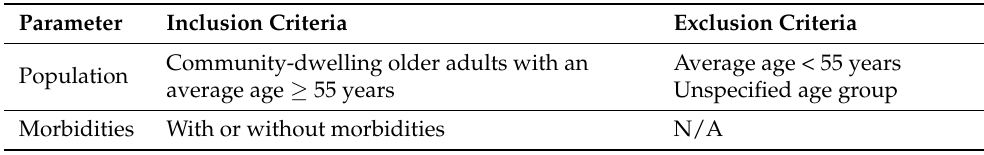
Table 2. Inclusion and exclusion criteria of selected